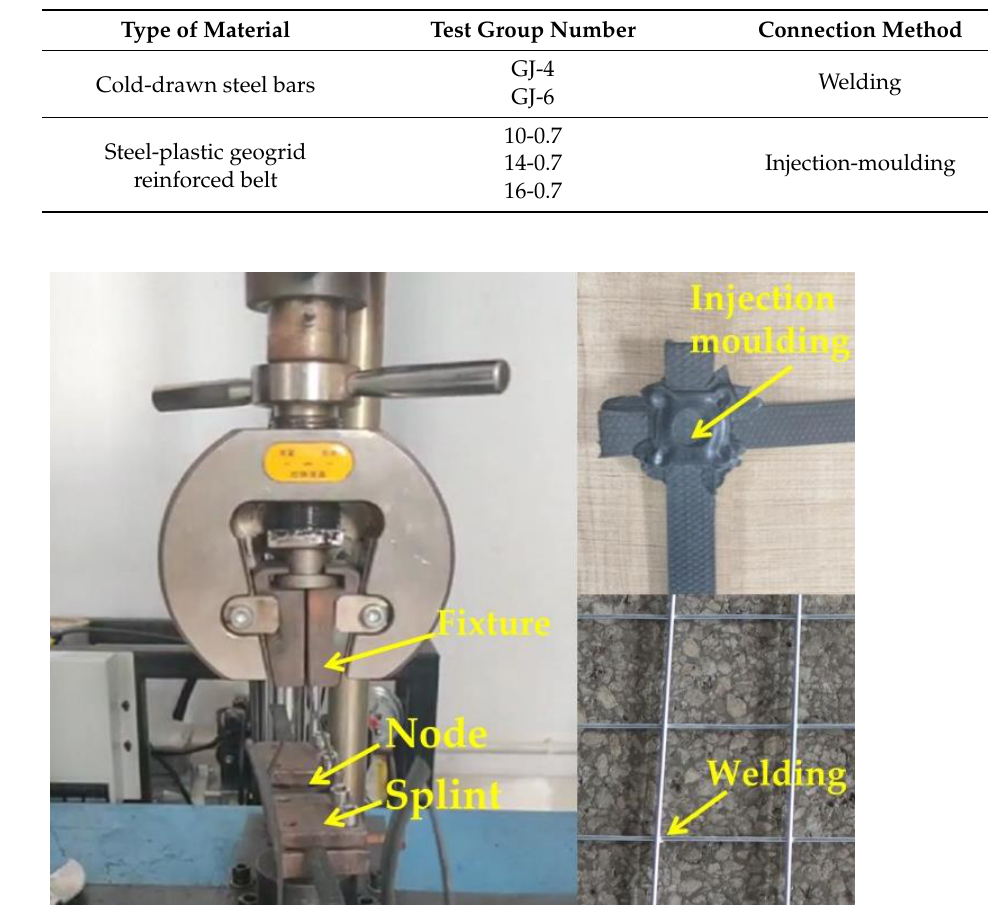
Figure 6. Test demonstrations.